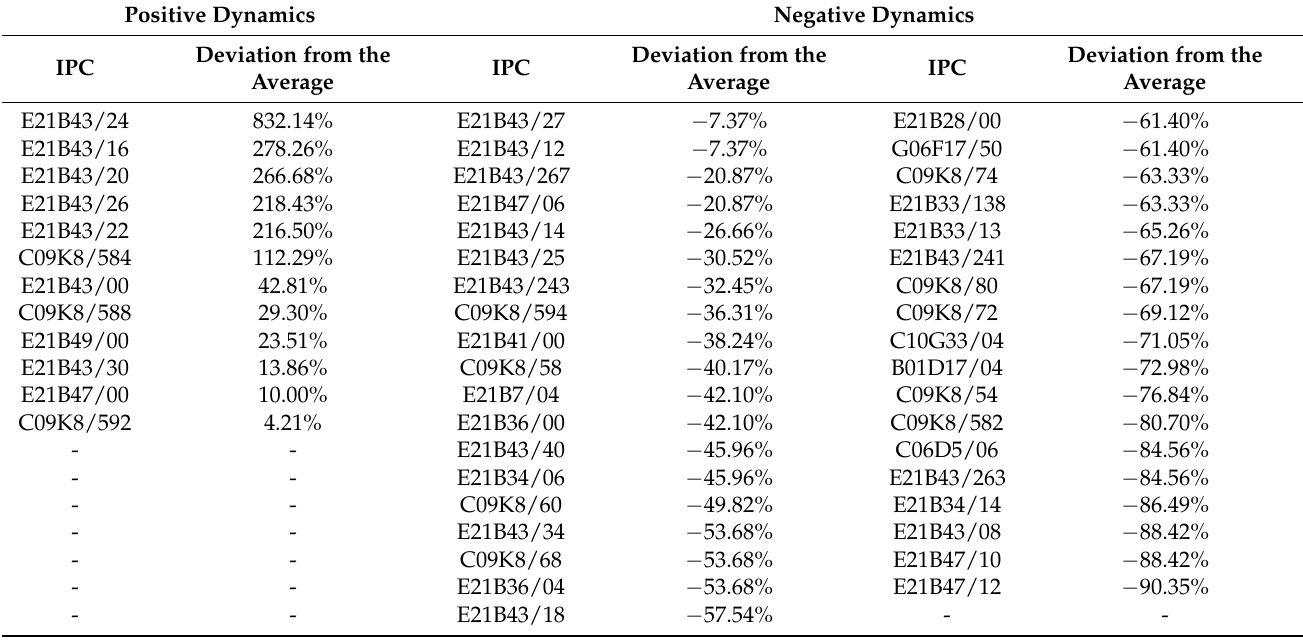
Table 3. Analysis of the sample for the period from 2010 to 2019 in accordance with the indices of the international patent classification in the field of increasing the efficiency of hydrocarbon